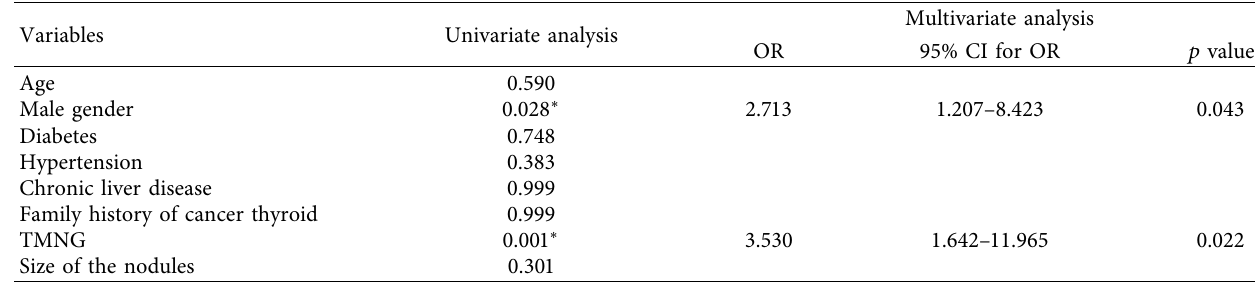
Table 3: Regression analysis to detect risk factors of malignancy in